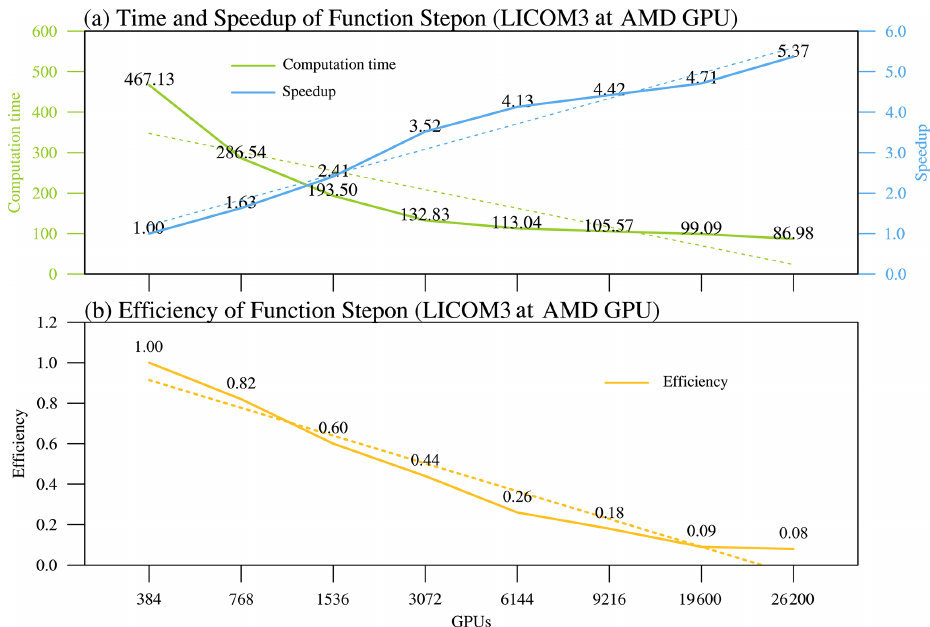
Figure 11. (a) Computation time (green) and speedup (blue) and (b) parallel efficiency (orange) at different scales for stepons of LICOM3- HIP (1 / 20 ◦